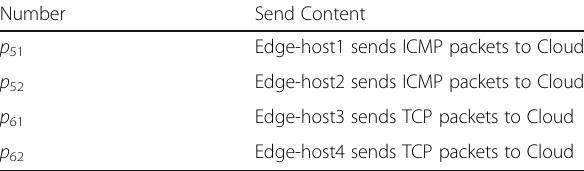
Table 2 Packet transmission information in the